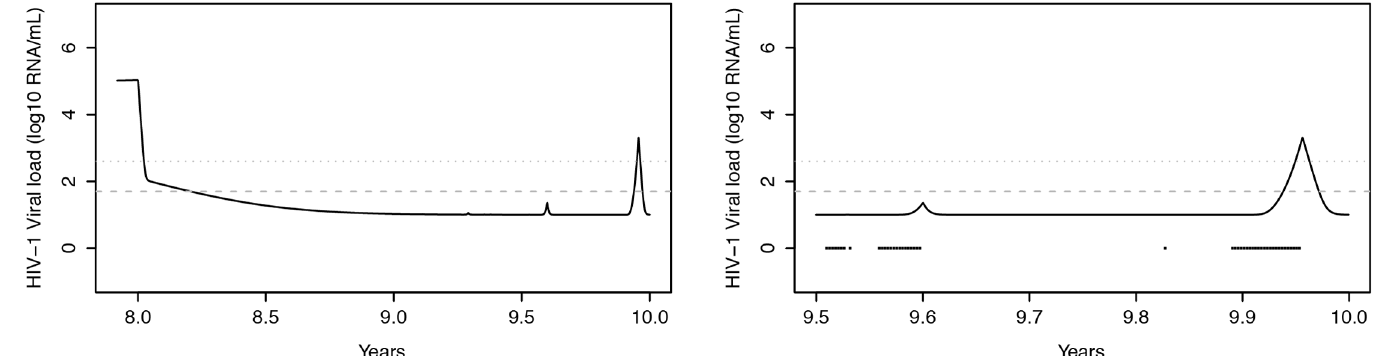
Fig 7. Treatment interruptions and viral response. Left: Plasma HIV-1 RNA levels as a function of time, simulated by the HIV-D model with drug effect modeled by the primary treatment regimen module of EPICE-HIV. The treatment considered is RPV/FTC/TDF, starting at 8 years after seroconversion with a theoretically imputed persistent low viremia level of 10 plasma HIV-1 RNA copies/mL. For comparability with Parienti et al. [45, 54] during the first year of therapy, 100% adherence was assumed, allowing for plasma HIV-1 RNA levels to be controlled (below 50 copies/mL). After that, adherence to therapy is driven by the first-order binary autoregressive adherence model. In the second year of therapy, the patient demonstrated 76% of adherence. Right: Close-up of the last half year of therapy, demonstrating two large treatment interruptions, represented by black squares: one of 15 days (around 9.6 years) and another of 24 days (around 9.9 years). The horizontal grey dashed and dotted lines correspond to viral load detection thresholds of 50 and 400 plasma HIV-1 RNA copies/mL, respectively. Though the 15 day interruption leads to drug concentrations that allow for viral replication, it is not long enough for plasma HIV-1 RNA levels to rise above the detection thresholds. The 24 day interruption leads to plasma HIV-1 RNA levels above 400 copies/mL. Several days after reintroduction of treatment, levels remain detectable by the 50 copies/mL threshold.